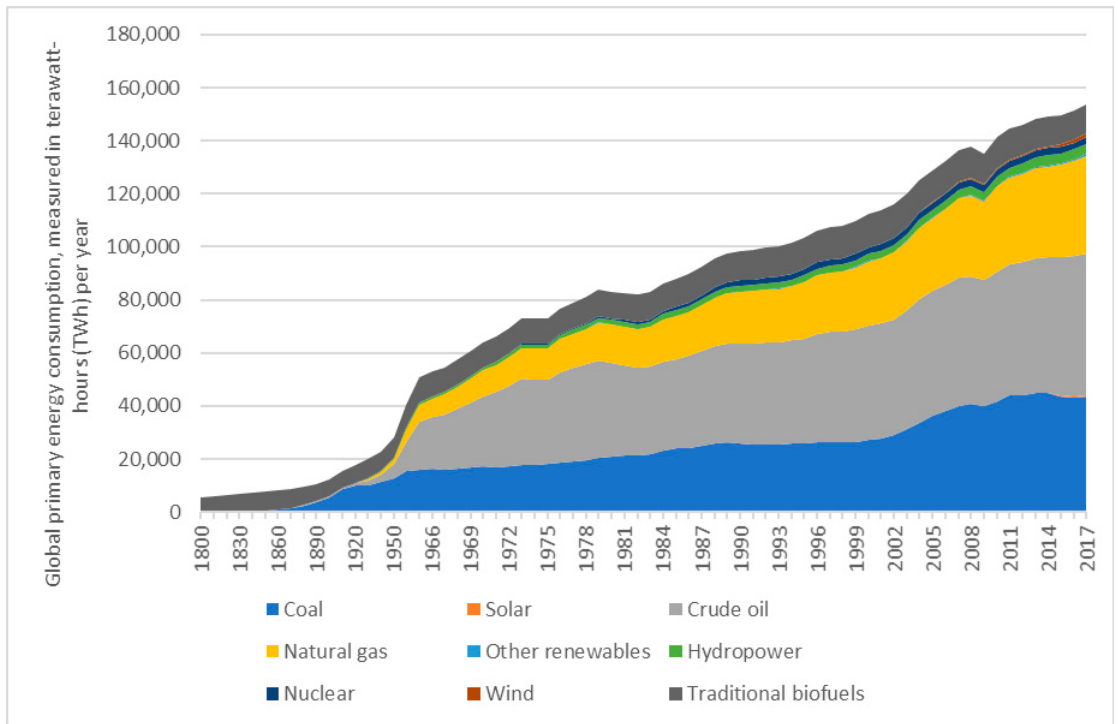
Figure 3. Global primary energy consumption 1800–2017 [19].